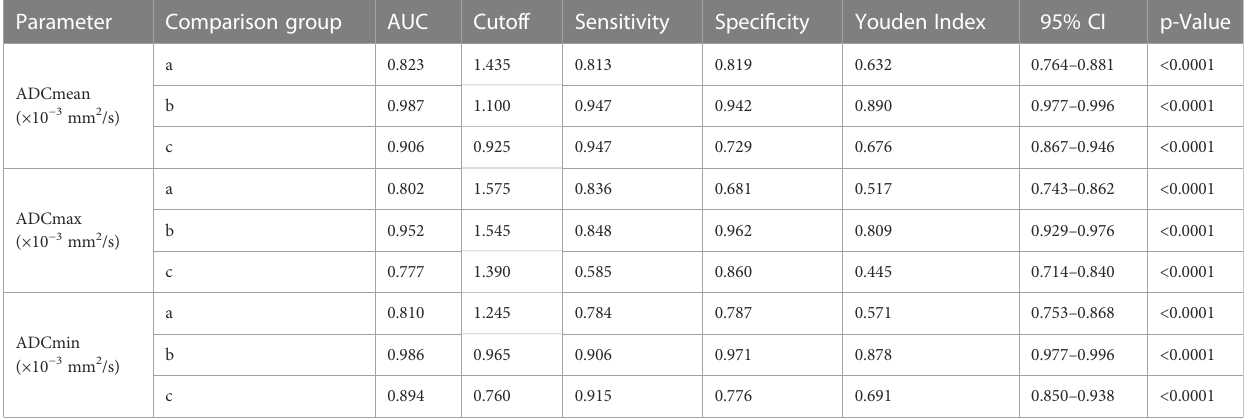
TABLE 1 Diagnostic performance of ADC parameters for differentiating between PTs, FAs, and BCs.